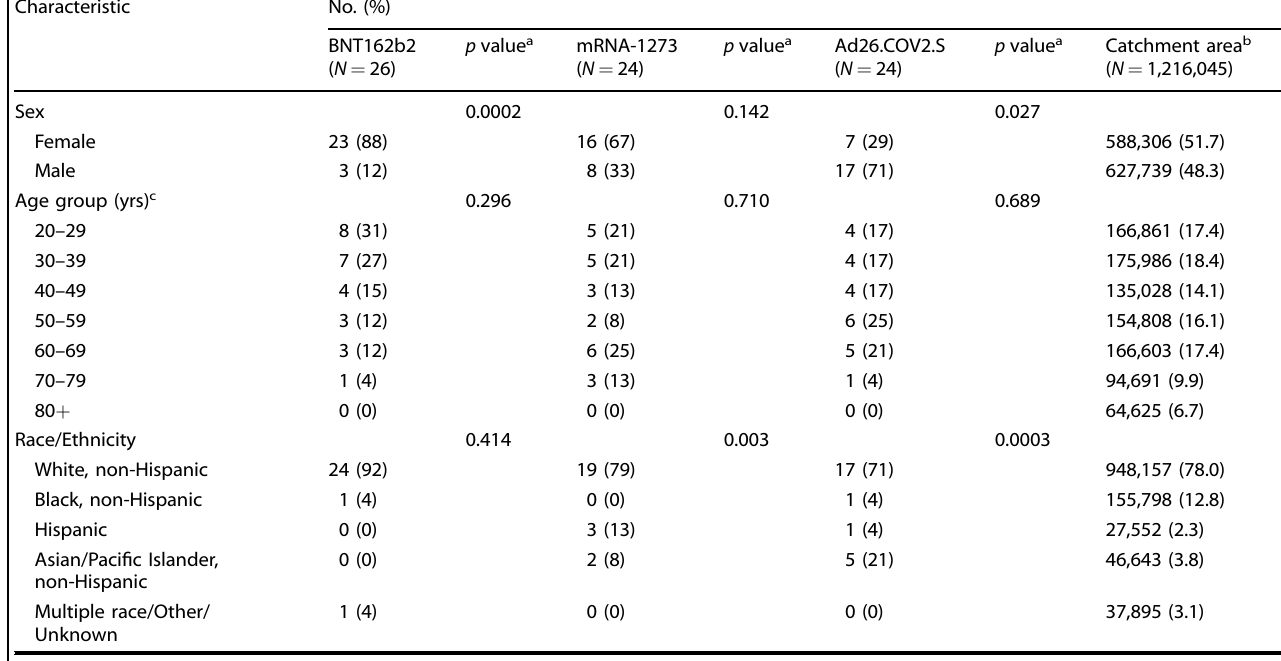
Table 1. Demographics of the study population.